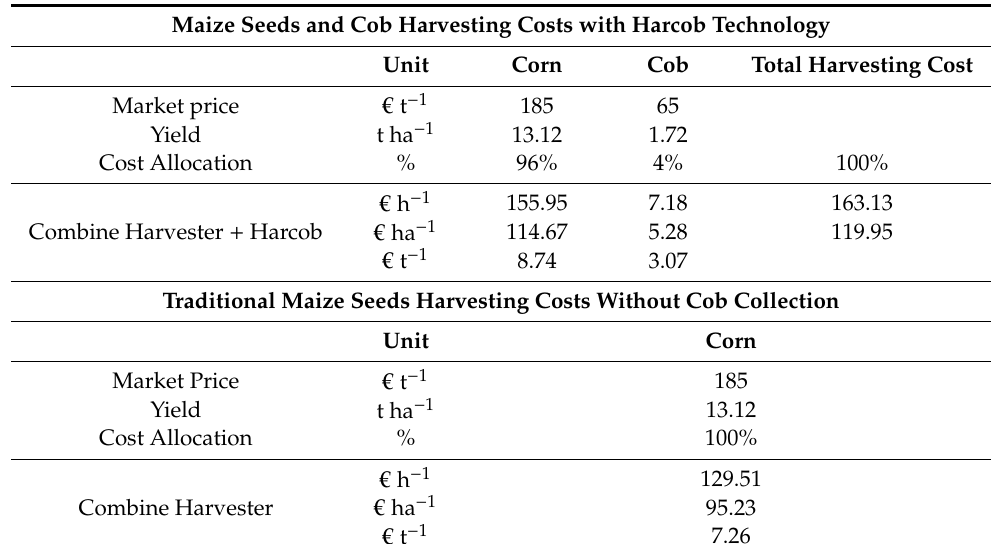
Table 5. Operating costs of maize seeds and cob harvesting. Comparison between traditional and Harcob